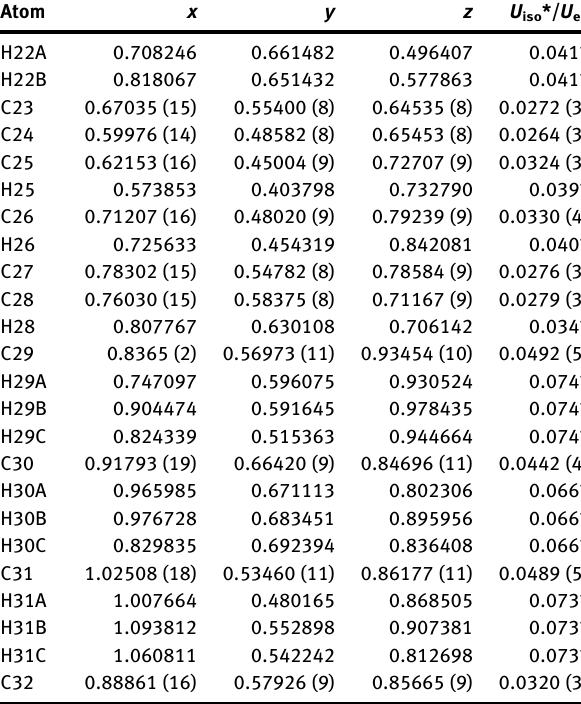
Table  : Fractional atomic coordinates and isotropic or equivalent isotropic displacement parameters (Å 